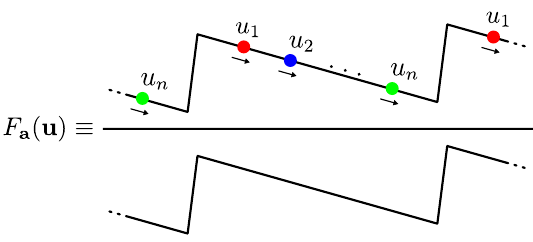
Figure 1 . The FF transition is defined as the amplitude of the two-sided wrapped polygon to absorb a GKP state. It is normalized in such a way that the FF transition for the GKP vacuum is equal to